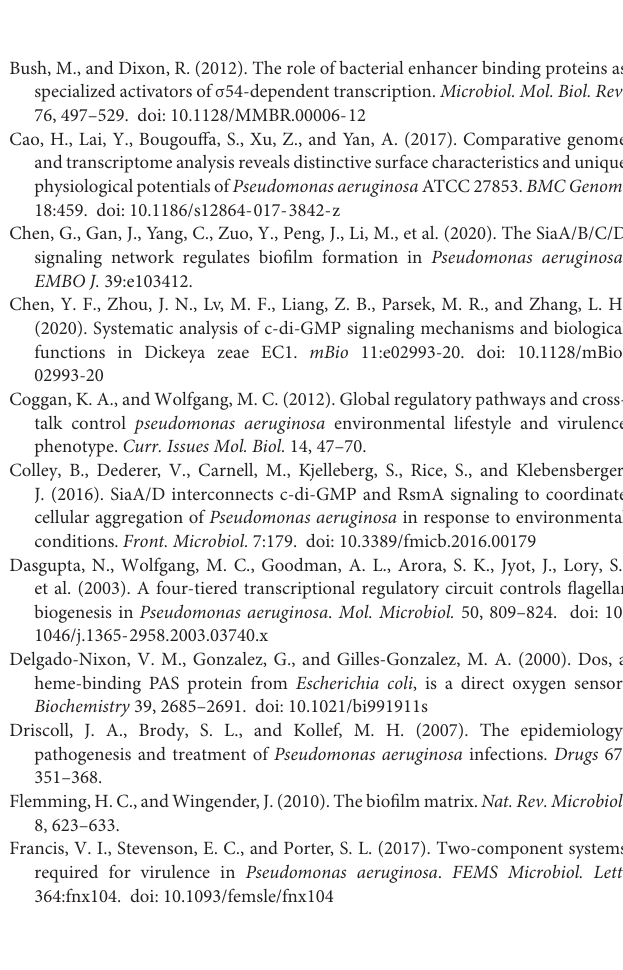
Supplementary Figure 1 | Stable expression of the FleS/FleR variants constructed in this study. Variants of FleS and FleR used in this study are His-tagged and examined by western blot. Supplementary Figure 2 | Schematic diagram showing the aspartate residues in the FleR-REC domain. The positions of each aspartate residue are shown. Supplementary Figure 3 | Alignment of the AAA domains from FleR and FleQ. Residues shown with 100% identity are highlighted in red. Supplementary Figure 4 | Alanine substitution of leucine at the position of 143 in the FleS-PAS domain inactivates the signaling activity of FleS. Supplementary Figure 5 | Alignment of the REC sequences from CheY and FleR. D12 and D57 in CheY with corresponding to the D10 and D53 residues in FleR are marked with red boxes. Supplementary Figure 6 | Sequence alignment of FleQ and FleR. Residues R144, R185, N186, E330, and R334 which are critical for c-di-GMP binding in FleQ are highlighted in red boxes. Supplementary Table 1 | Bacterial strains and plasmids used in this study. Supplementary Table 2 | PCR primers used in this